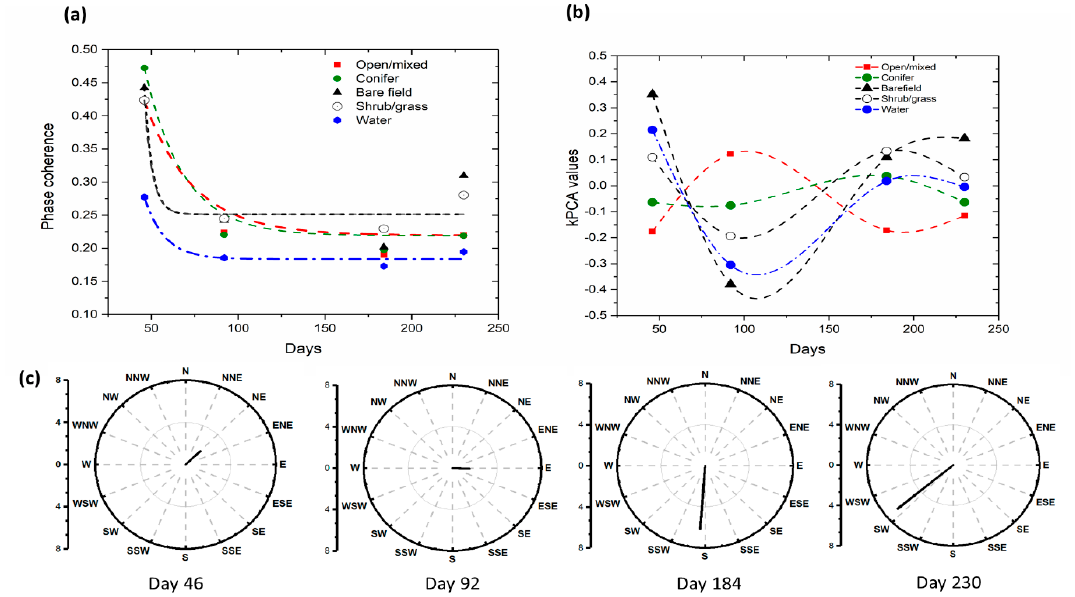
Figure 4. ( a ) The temporal phase coherence migrations of land cover types in HH2 packet; ( b ) The temporal patterns of transformed k-PCA components; ( c ) Wind components of pairs in HH2 packet, those were extracted from the ECMWF model.